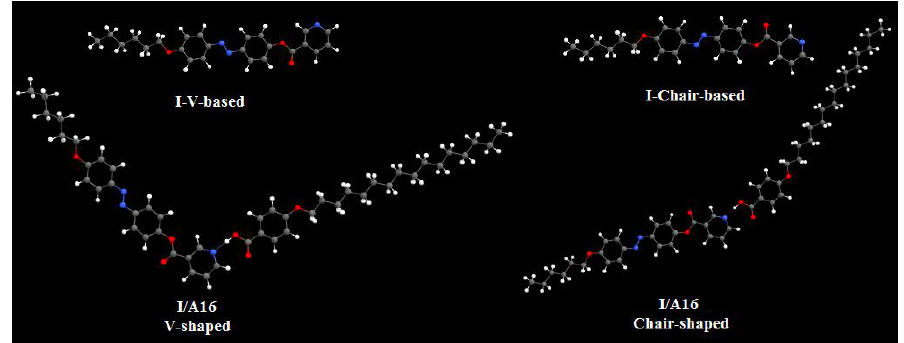
Figure 5. The calculated molecular geometrical conformers of the base I , and their SMHBCs, I/A16.